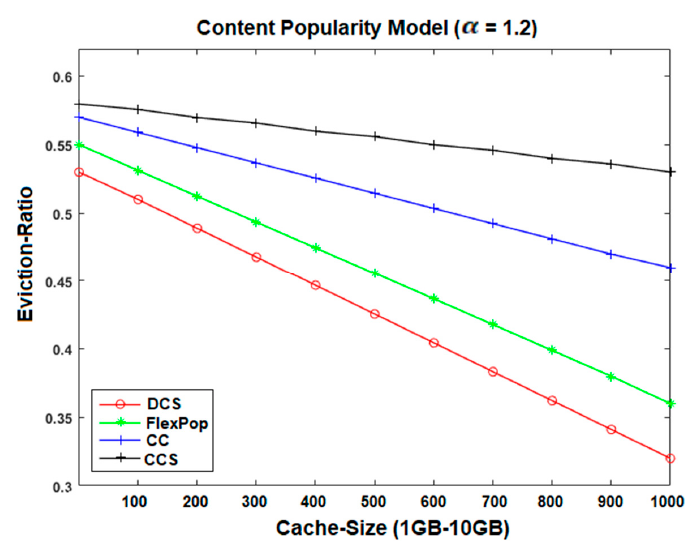
Figure 14. Content Eviction Ratio on GEANT Topology with VoD.